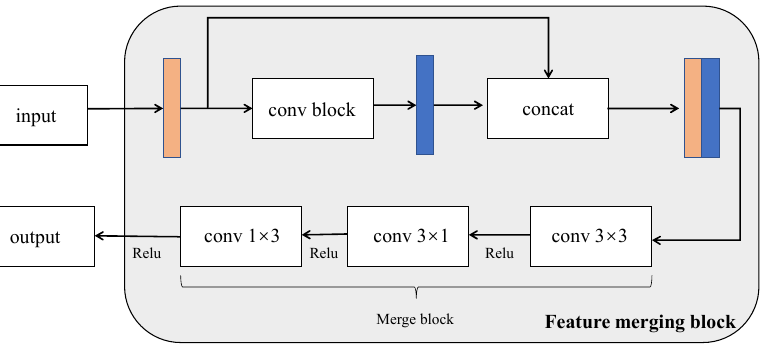
Figure 5. The architecture of feature merging block. The conv block of the feature merging block 1 (Figure 3) is the down-convolution block and the conv block of the feature merging block 2 (Figure 3) is the information exchange